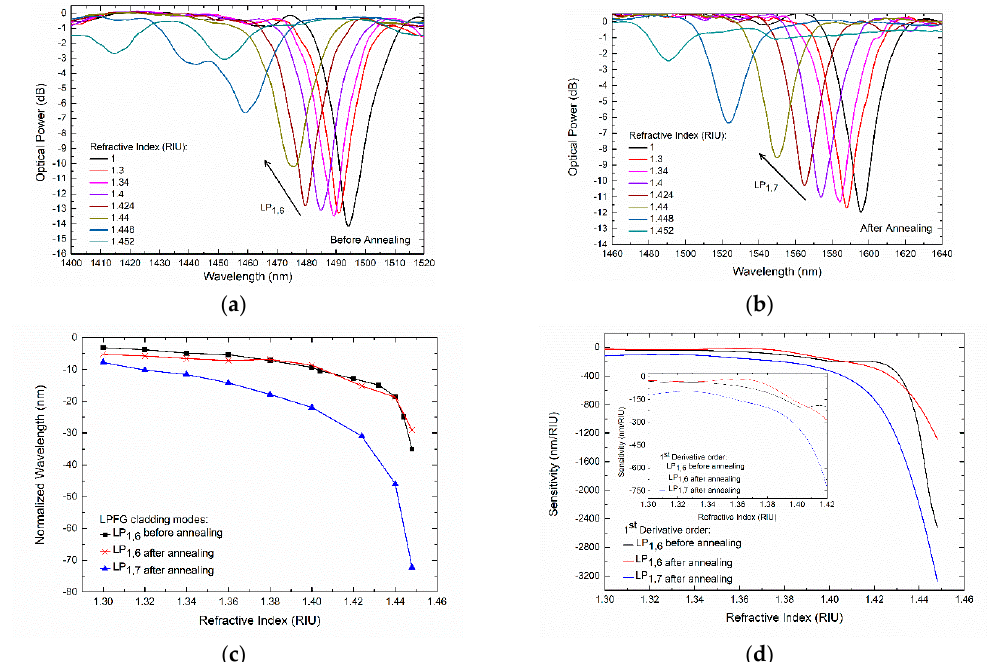
Figure 3. LPFG: ( a ) measured transmission spectra for the cladding mode LP 1,6 before annealing; ( b ) measured transmission spectra for the cladding mode LP 1,7 after annealing; ( c ) normalized wavelength variation with the surrounding refractive index; ( d ) wavelength sensitivity as a function of the surrounding refractive